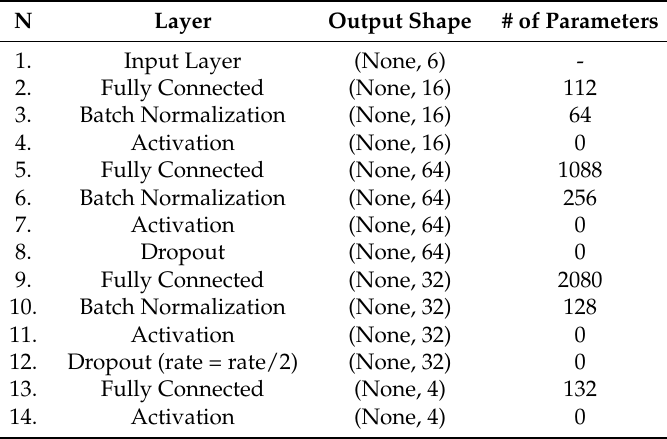
Table A1. JSON submodel’s